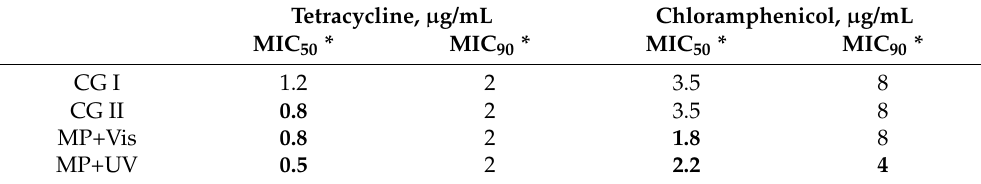
Table 1. The susceptibility of bacteria cells to antibiotics before and after treatment with C-TiO 2 +Ni. Tetracycline, µ g/mL Chloramphenicol, µ g/mL MIC 50 * MIC 90 *